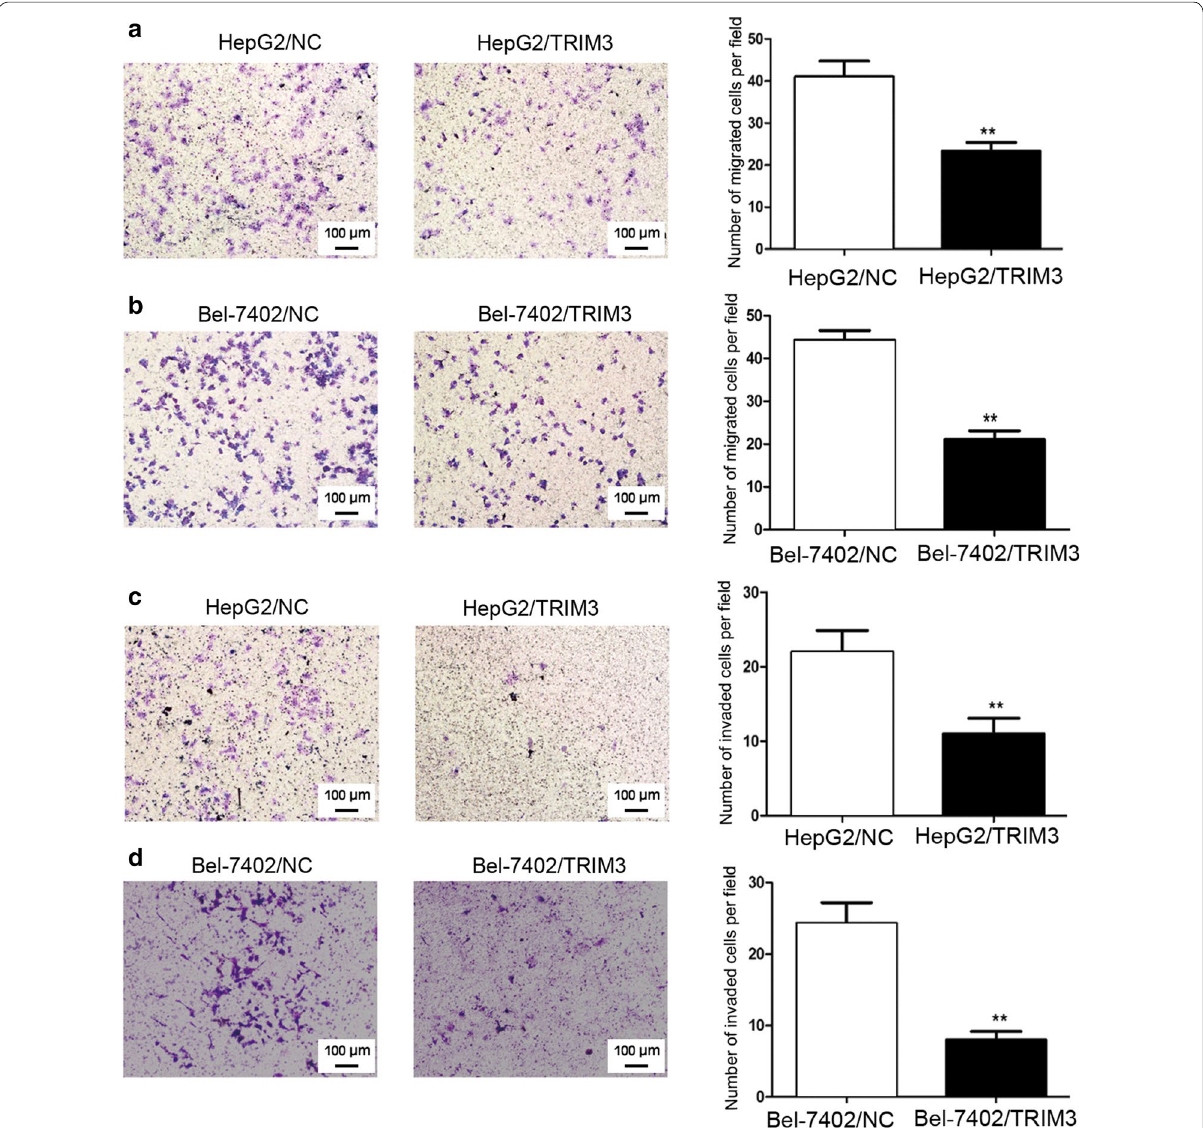
Fig. 6 Overexpression of TRIM3 suppressed migration and invasion of HepG2 and Bel‑7402 cells. Representative images of cell invasion and migra‑ tion are shown on the left ( 100 magnification), and quantification of migrated or invaded cells in 10 randomly selected fields are shown on the × right . a , b TRIM3 overexpression inhibited migration of HepG2 ( a ) and Bel‑7402 ( b ) cells. c , d TRIM3 overexpression significantly attenuated invasion of HepG2 ( c ) and Bel‑7402 ( d ) cells. Data are shown as mean SD of three independent experiments. P values were calculated using Student’s ± t ‑test. * P < 0.05, ** P < 0.01, and *** P < 0.001, versus cell transfected with